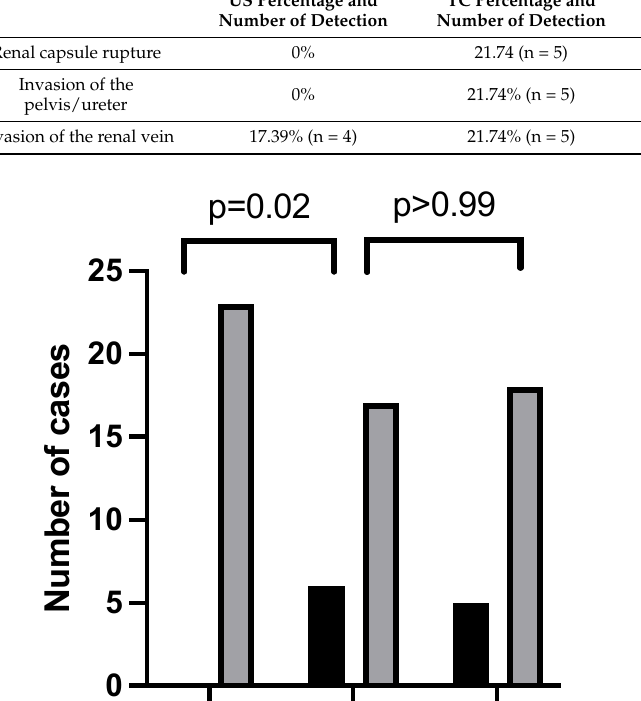
Figure 10. Pelvis/ureteral invasion evaluation by US/CT comparative to histopathological exami- nation.